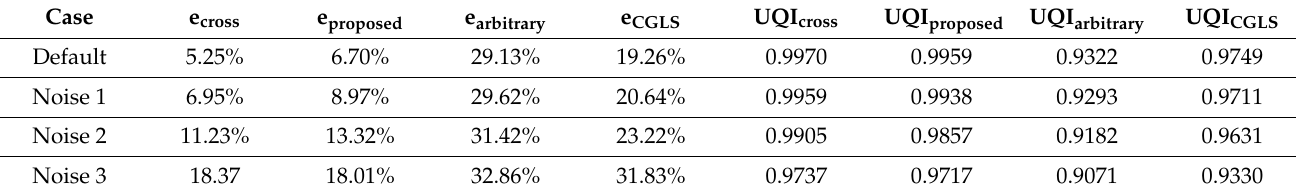
Table 3. Relative errors and UQI of image reconstruction results with XCAT Thorax